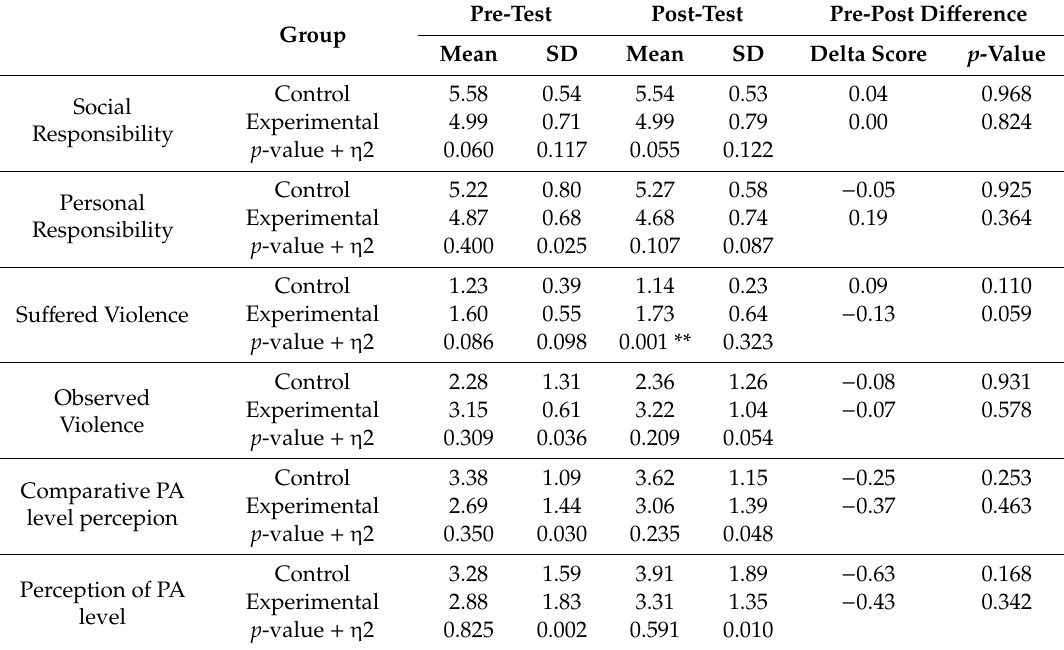
Table 3. Analysis of intervention results